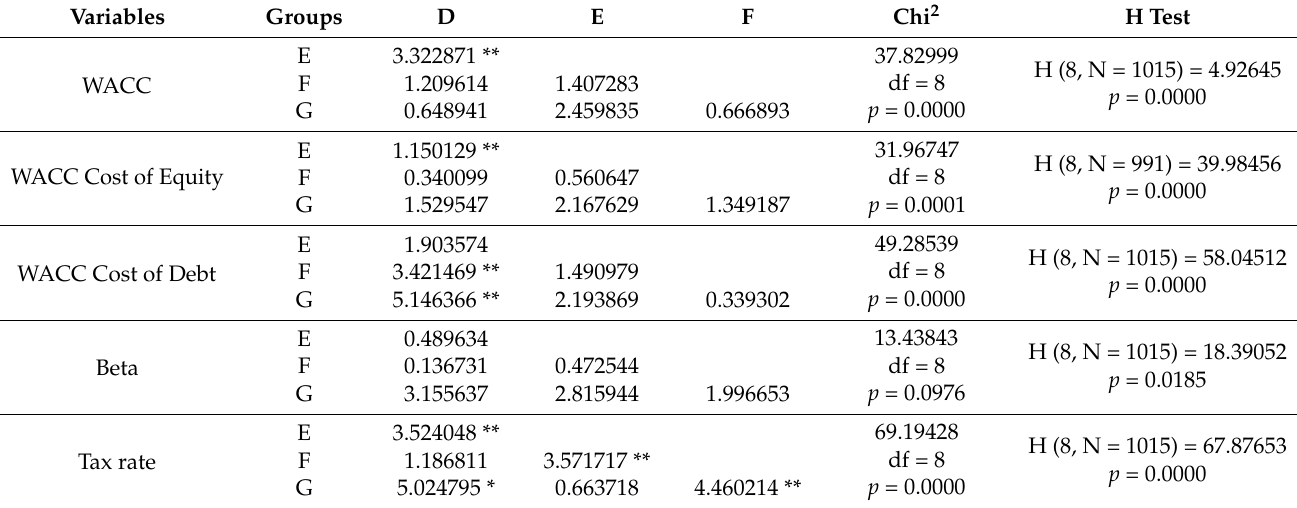
Table 10. Summary statistics H Kruskal–Wallis test—post hoc tests pairwise comparisons with group